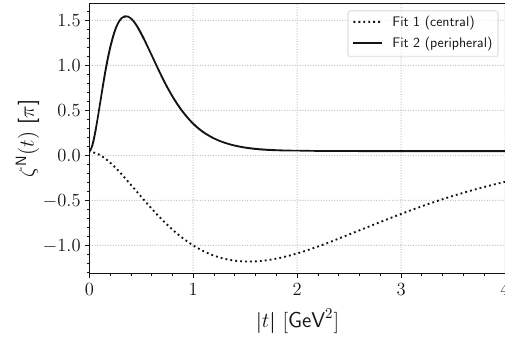
Fig. 8 Elastic hadronic phases ζ N ( s , t ) for central and peripheral pic- tures of elastic pp scattering (Fits 1 and 2) at energy of 8 TeV